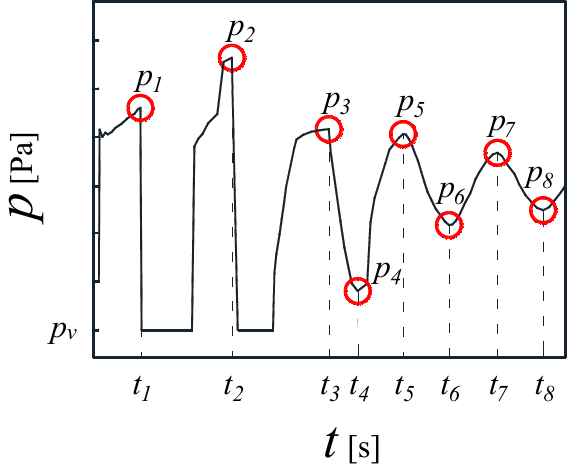
Figure 6. Selection of maximal and minimal pressures and their times of occurrence.